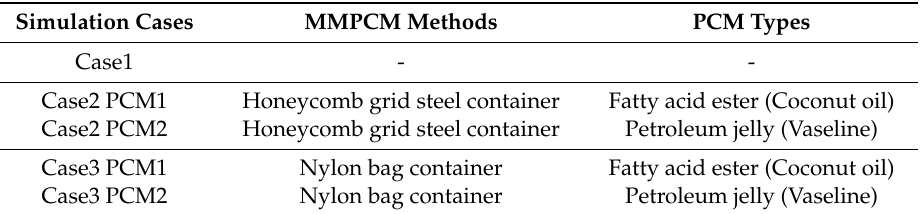
Table 2. Details for the simulation